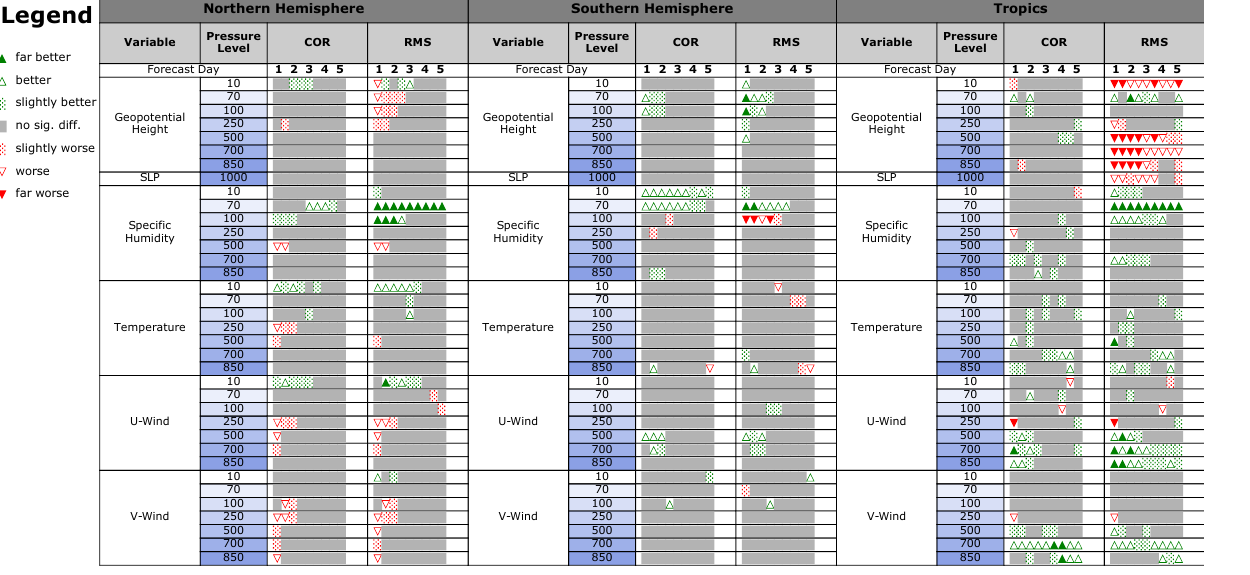
Figure 15. Same as in Figure 12, but for comparing the present configuration of GEOS ADAS, which assimilated H-8 AMVs (CNTL), with the experiment GK2AH8 which adds GK2A AMVs to